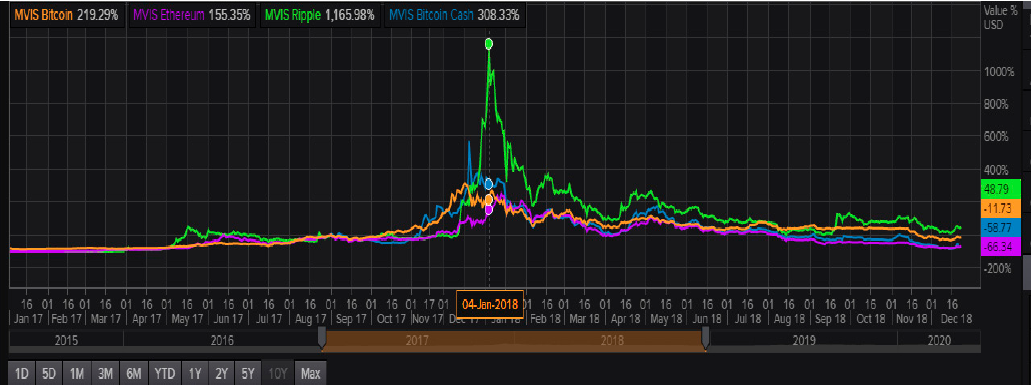
Figure 5. The Great Crypto Crash. Source: Authors’ own processing based on Thomson Reuters data.